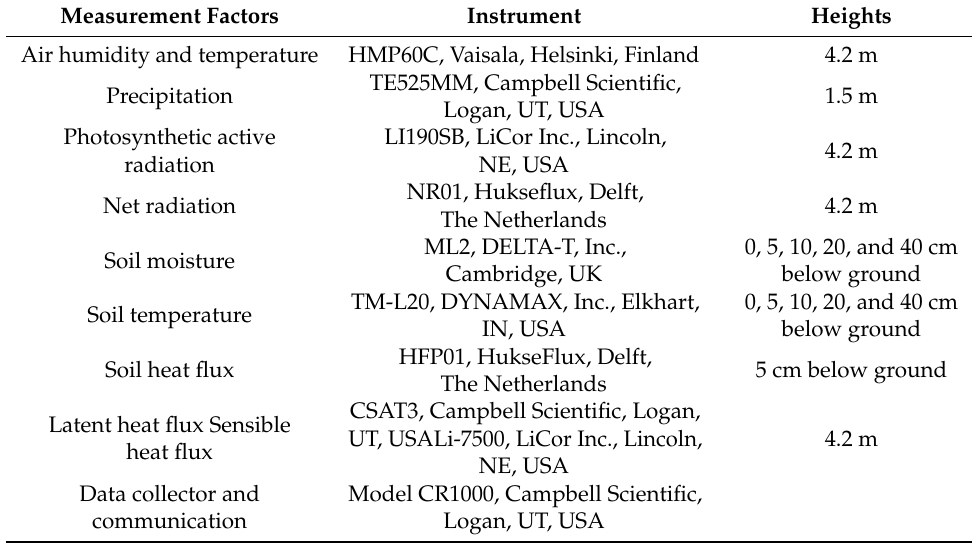
Table 1. Description of eddy covariance and microclimatic and solar radiation